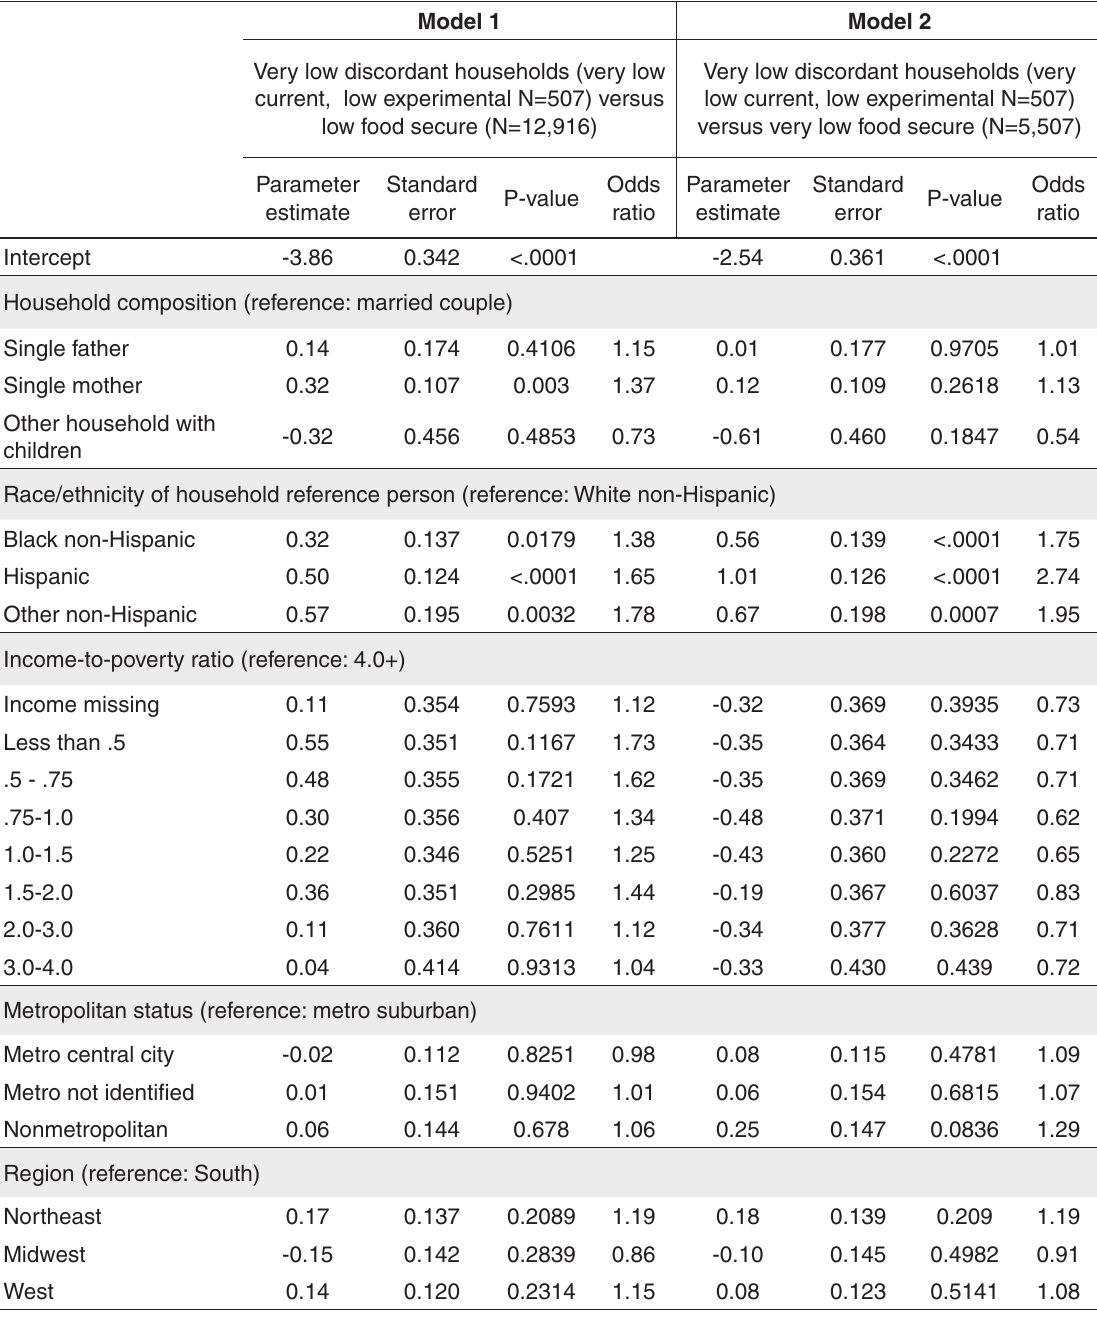
Logistic regression model comparing very-low-food-secure discordant households (very low food secure current, low food secure experimental) with households consistent on both classification methods,